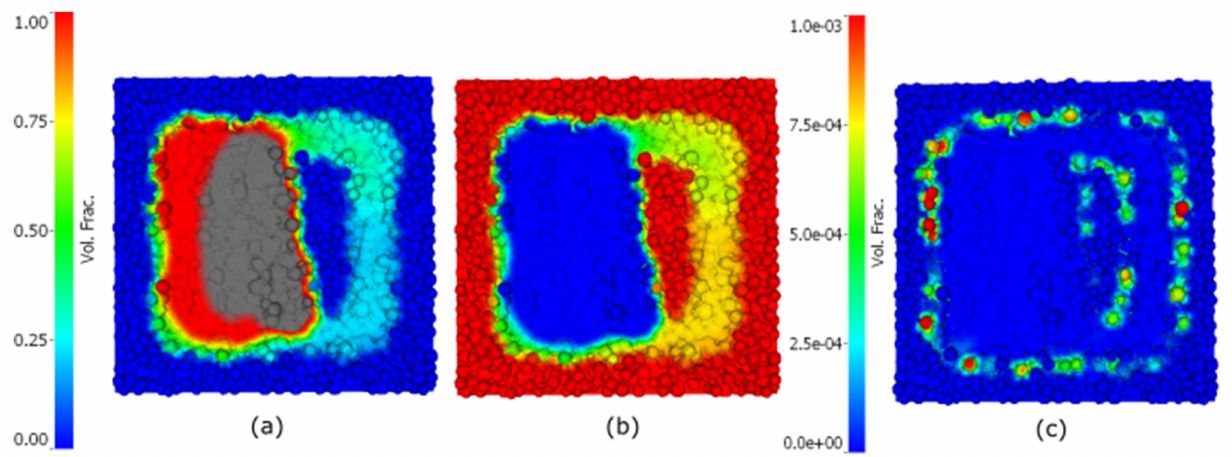
Figure 7. Volume fractions of microstructure phases of the powder bed at time t = 0.009 s ( a ) β ; ( b ) α ms ; ( c ) α wid . The grey section in the β plot denotes the melted Ti-6Al-4V